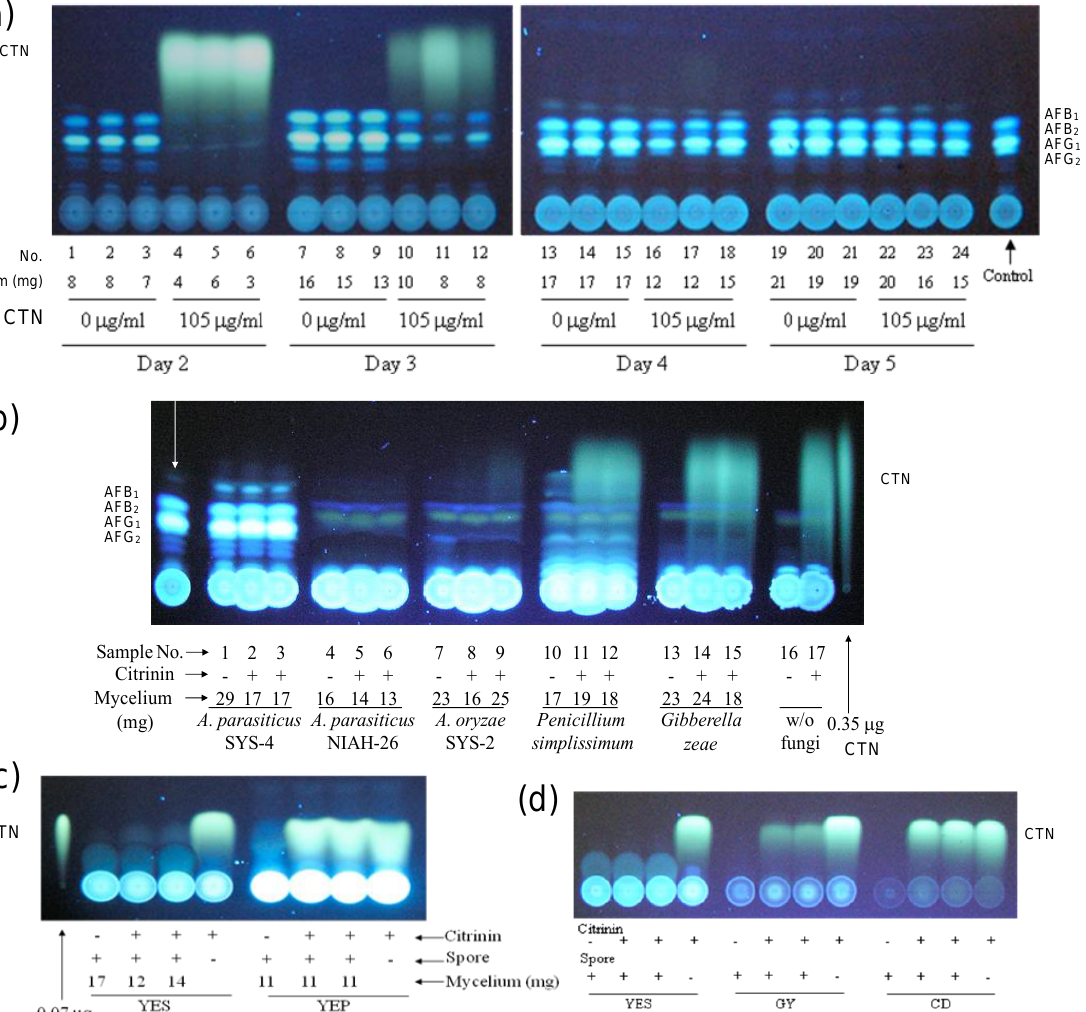
cence. These results suggested that substance B was a heat-stable substance excreted from the cells. When the filter-sterilized culture medium was incubated with CTN at various tem- peratures for 3 h (Figure 5a), the CTN was decreased at 50  C and 70  C, whereas the use of YES medium did not show a decrease in the yellow fluorescence of CTN, indicating that a higher temperature accelerated the decrease in CTN fluorescence by substance B. The pH dependency of the decrease in CTN fluorescence was also examined at 50  C for 3 h (Figure 5b). The CTN was significantly decreased at all pH conditions used. However,